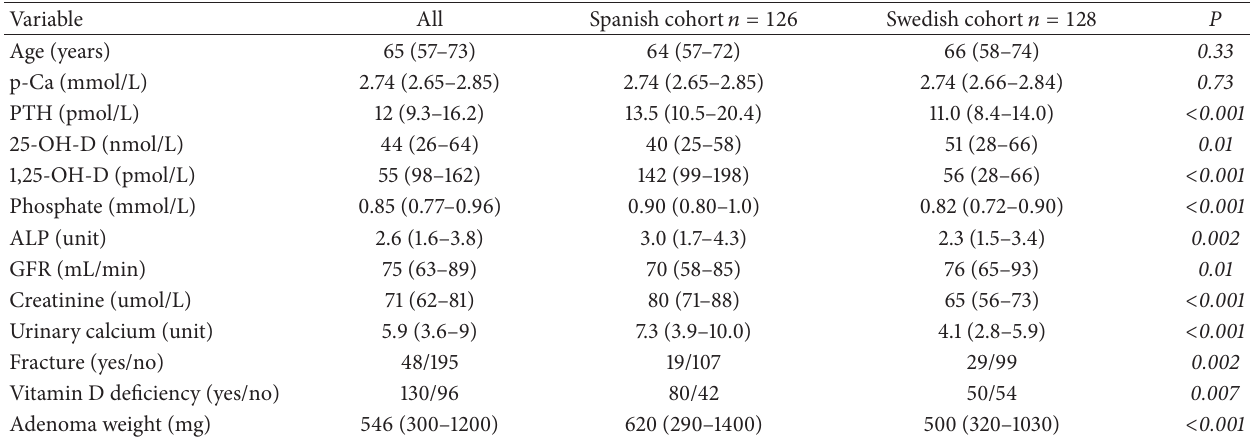
Table 1: Pre- and perioperative biochemical and clinical variables in patients operated on for primary hyperparathyroidism. Median, (IQR). Groups compared with Kruskal-wallis and chi square where